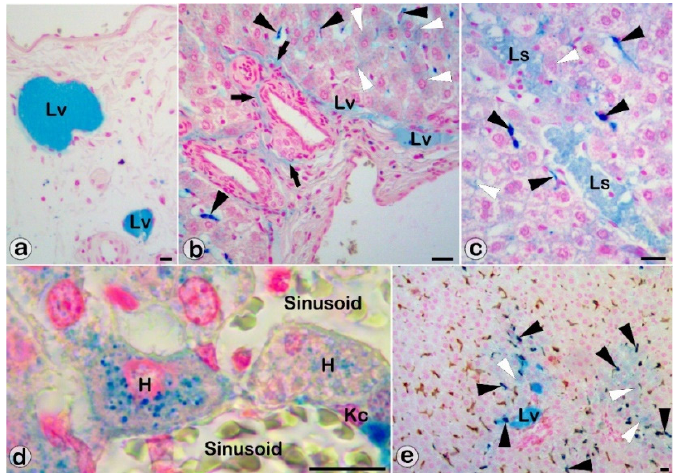
Figure 2. SaIONP deposits in liver compartments: lymphatic vessels (Lv) of the hepatic hilum ( a ), lymphatic vessels and connective tissue (black arrows) of the Moll space ( b ), interlobular sacciform lymphatic spaces (Ls) ( c ), and Kupffer cells (Kc, black arrowheads) and hepatocytes (H, white arrowheads) ( b – e ). Viscera harvested 24 h after IG ( a – d ) or IV ( e ) SaIONPs administration. Perls Prussian blue ( a – d ) and anti-Iba-1 ( e ) stainings. Bar = 10 µ